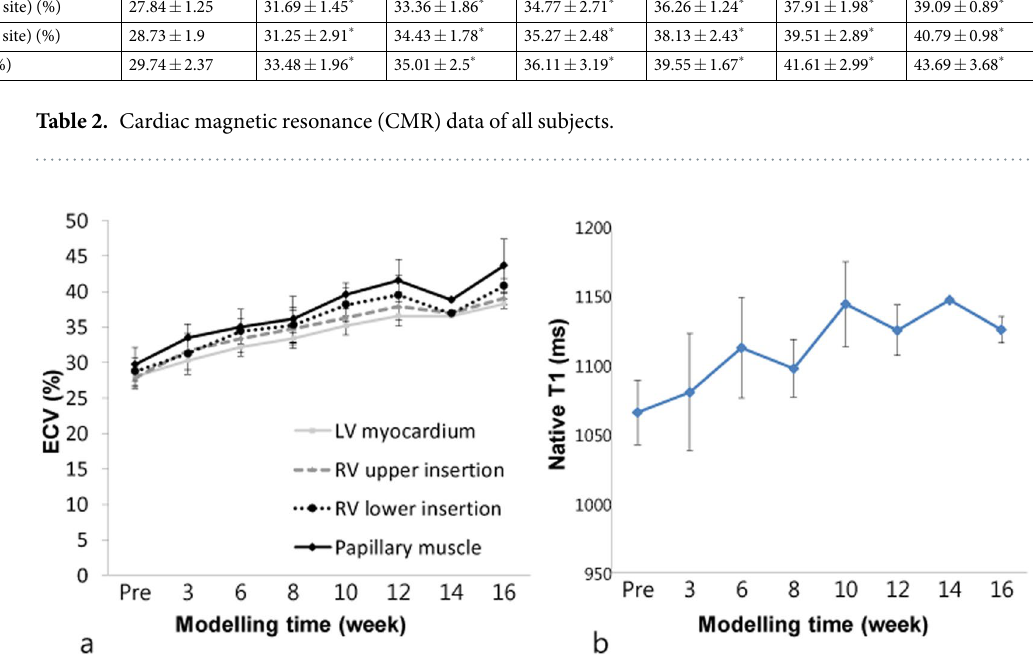
3 SCIentIfIC REPoRtS | 7: 2663 | DOI:10.1038/s41598-017-02627-x